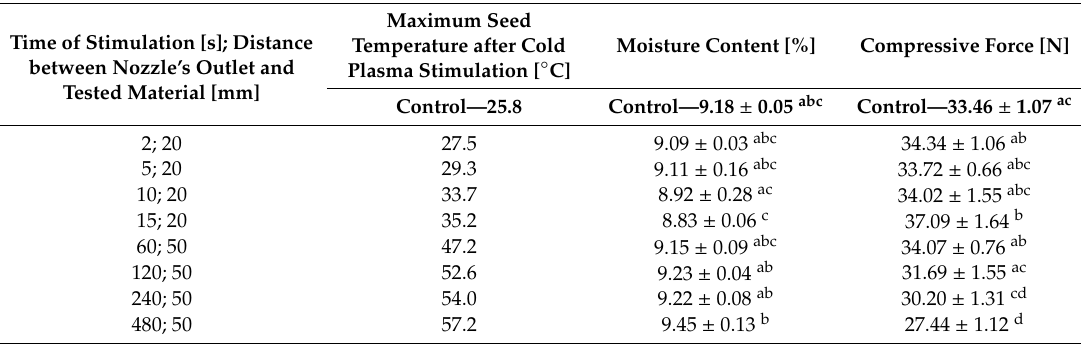
Table 1. Selected physical parameters of onion